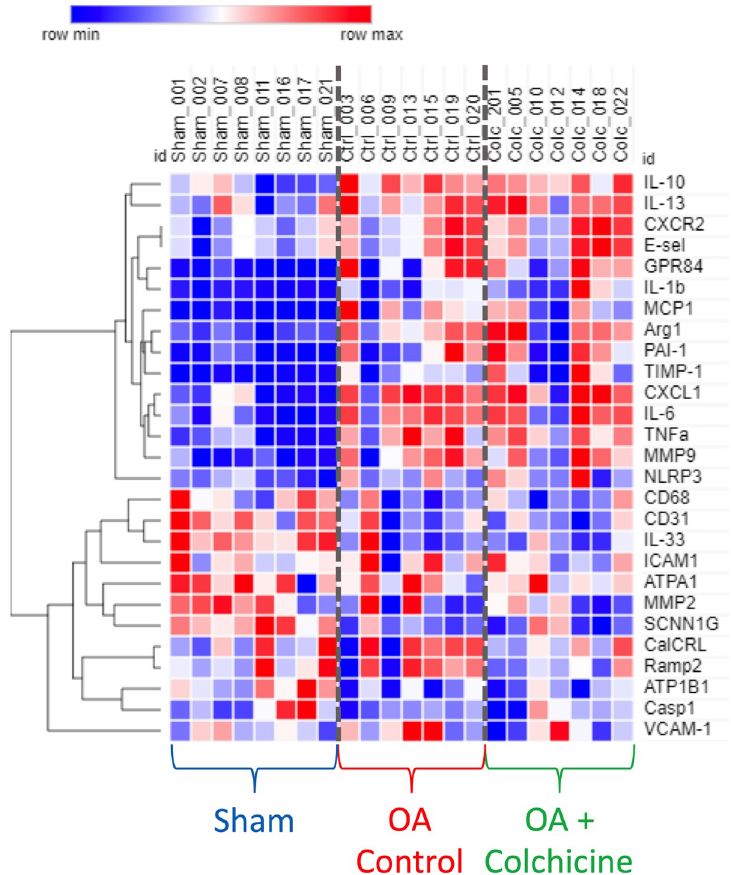
Fig 5. Clustered heatmap representation of unsupervised clustering of lung tissue mRNA expression of 27 selected markers of inflammation and injury.